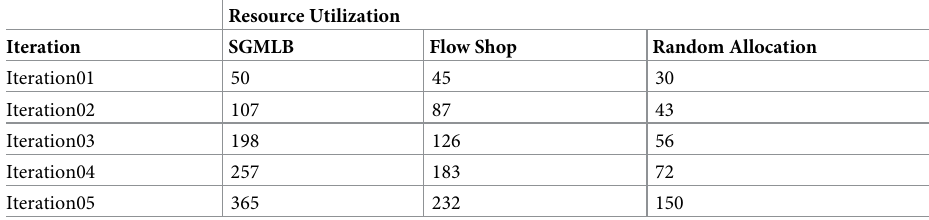
Table 4. Resource utilization in every iteration.